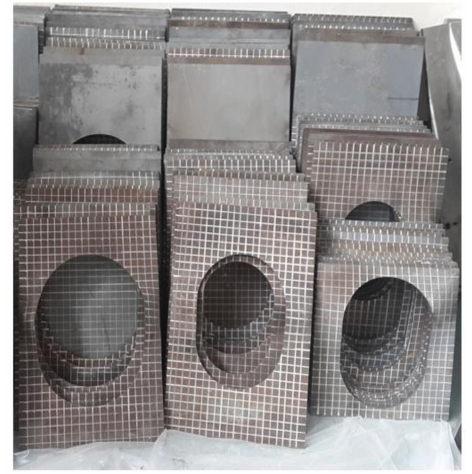
Figure 3. Specimens of the perforated plate after buckling